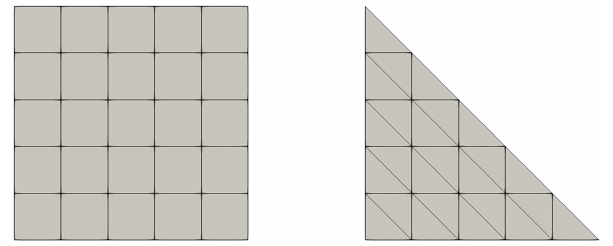
Figure 1. Reference square and triangle meshes at level 5 .